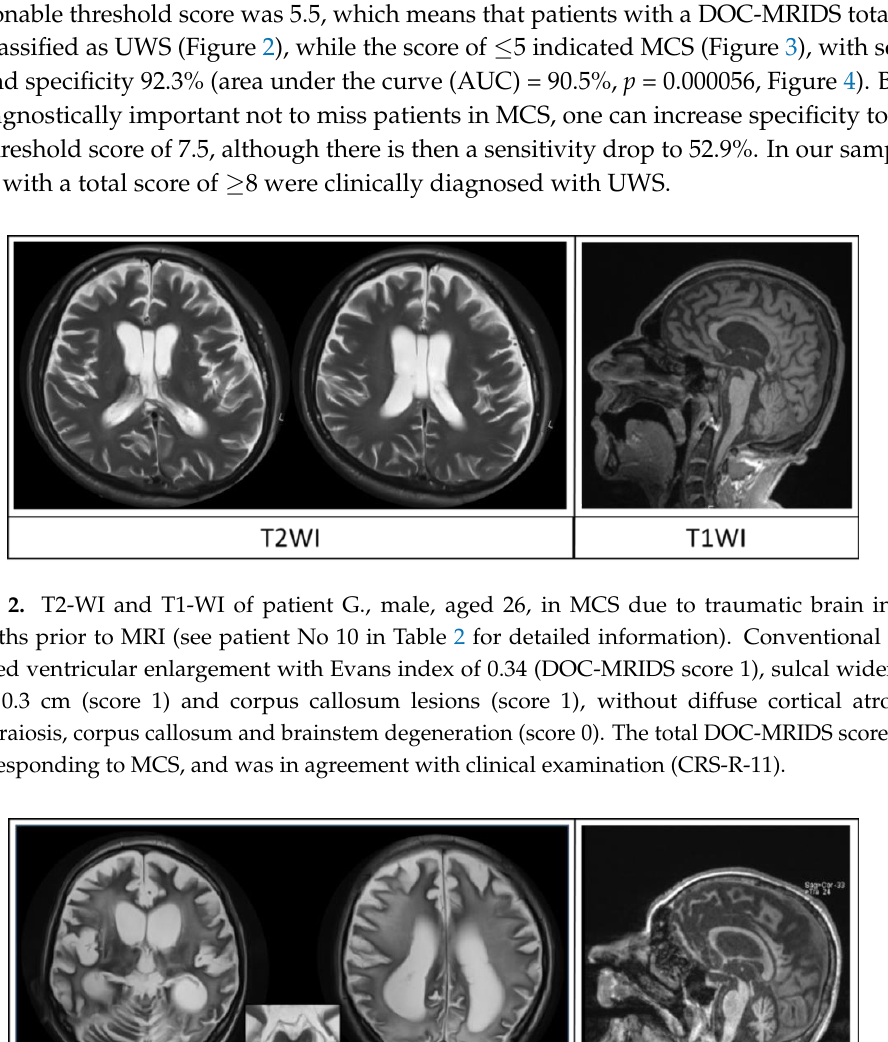
Figure 4. ROC curve for discrimination between UWS and MCS patients. AUC = 90.5%, p = 0.000056. Spearman correlation analysis showed significant negative correlation between CRS-R score and